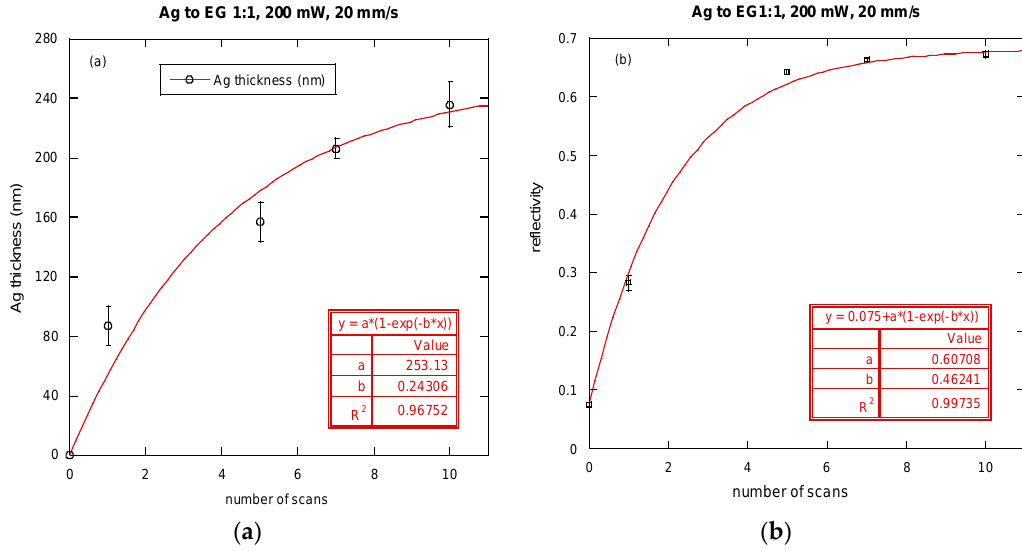
Figure 7. ( a ) Thickness of the silver film; ( b ) Reflectivity for 532 nm wavelength light versus number of laser scans (symbols: experimental data, lines: fitted curves).